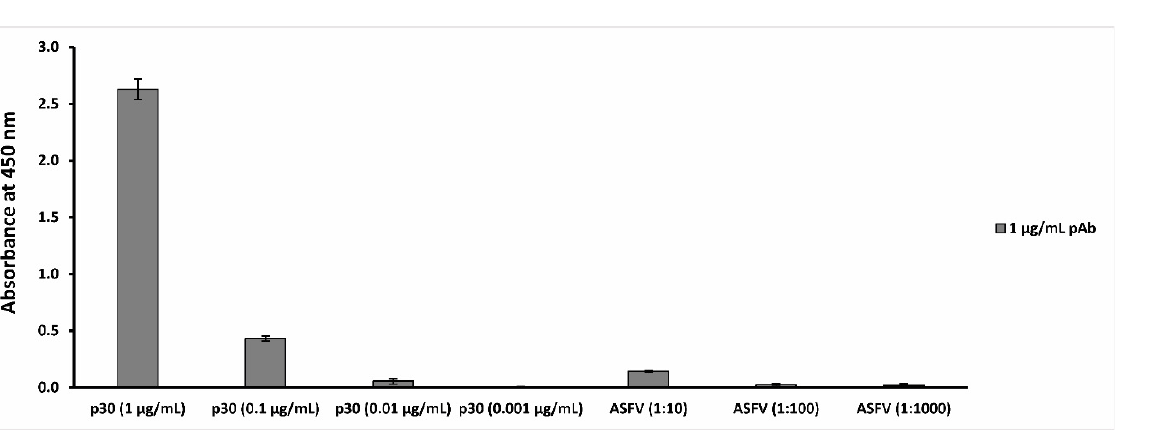
Figure 1. Anti-ASFV antibody binding capability evaluation. The figure reports the analysis of the results obtained by the indirect ELISA tests, in which p30 antigen was recognized up to 0.01 µg/mL, while the ASFV Pol19/54204 sample was recognized up to a 1:10 dilution.